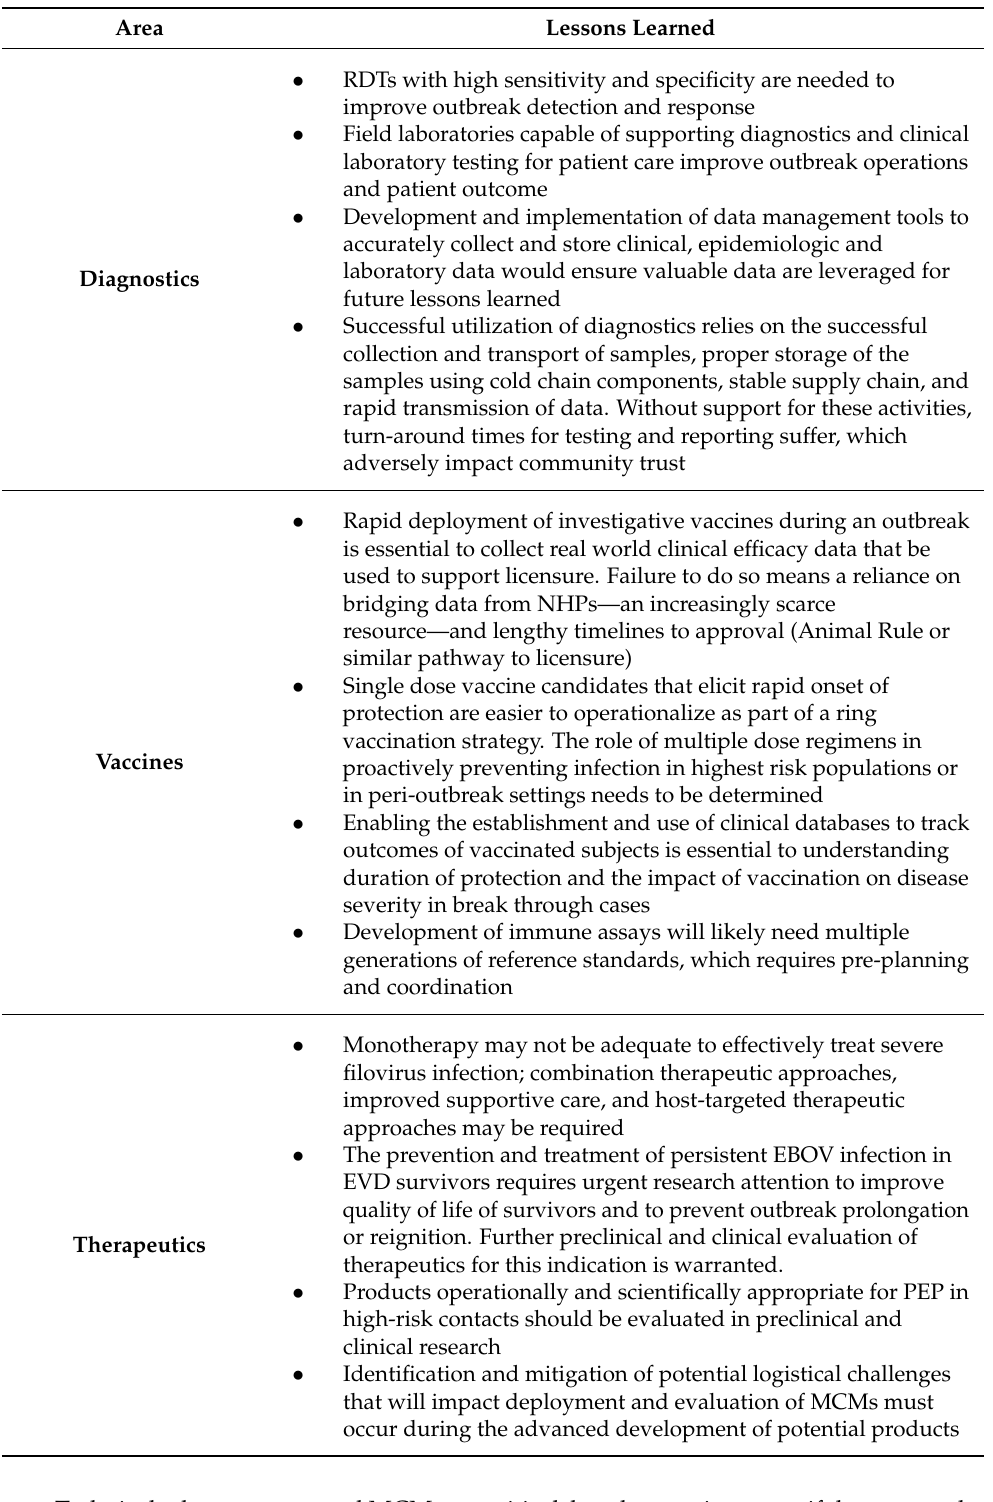
Table 2. Lessons Learned from the USG response to EBOV